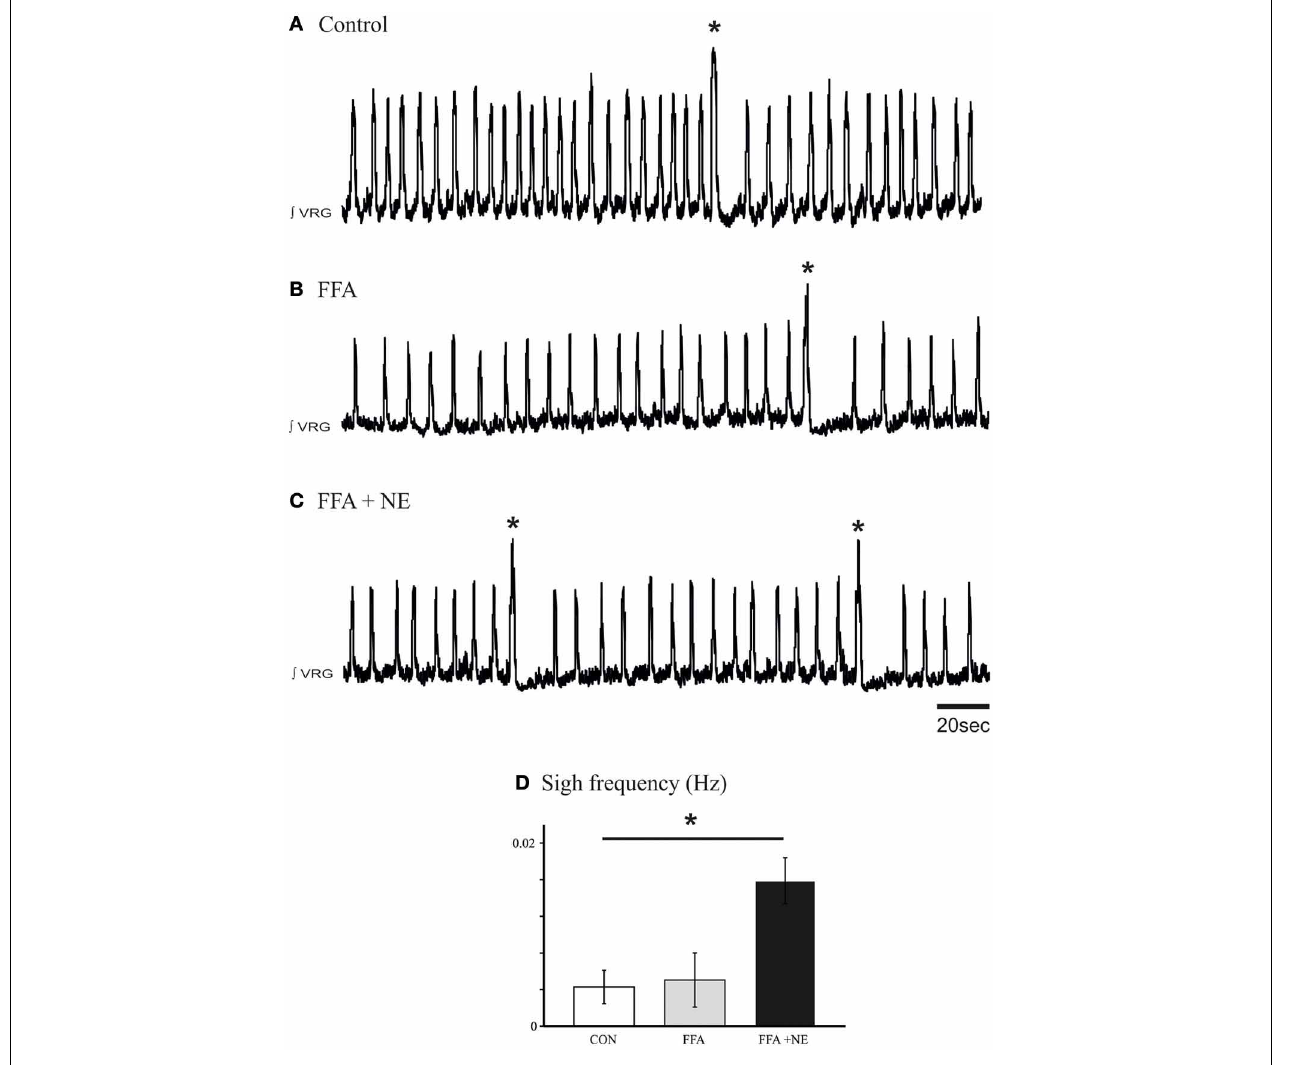
FIGURE 8 | Blockade of I CAN with FFA does not block the β -noradrenergic modulation of sigh activity. (A) Fictive sigh activity recorded in a control medullary slice preparation. (B) Application of FFA (50–500 μ M) does not affect the frequency of sigh activity